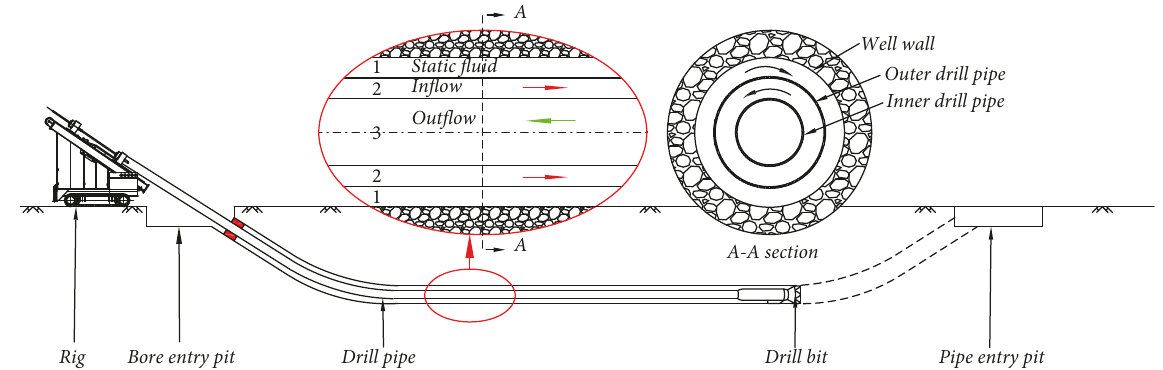
Figure 1: Schematic diagram of the dual drill pipe directional drilling system: in the figure, 1 represents the annulus between the outer drill pipe and the well wall; 2 represents the annulus between the inner drill pipe and the outer drill pipe; 3 represents the center hole of the inner drill